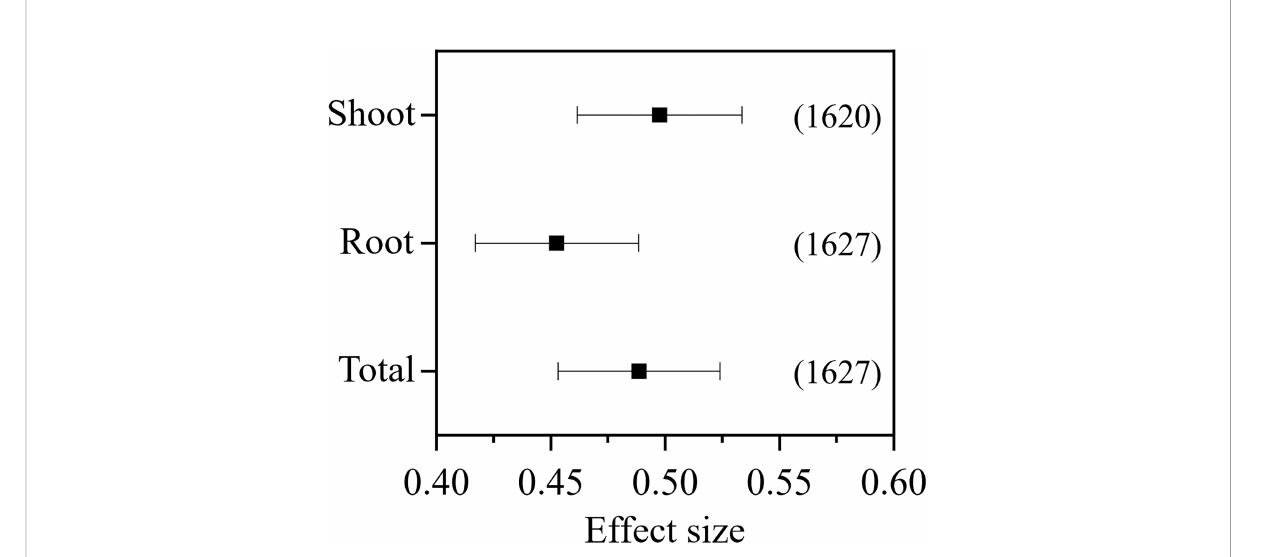
FIGURE 1 Effect of arbuscular mycorrhizal fungi (AMF) inoculation on the plant shoot, root, and total